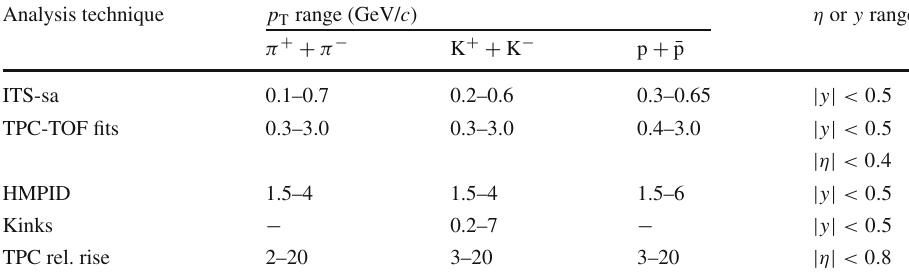
Table 2 Summary of the kinematic ranges ( p T (GeV/ c ) and η or y ) covered by the individual analyses for the measurement of π ± , K ± and ( ¯ p ) p in pp collisions at √ s = 13